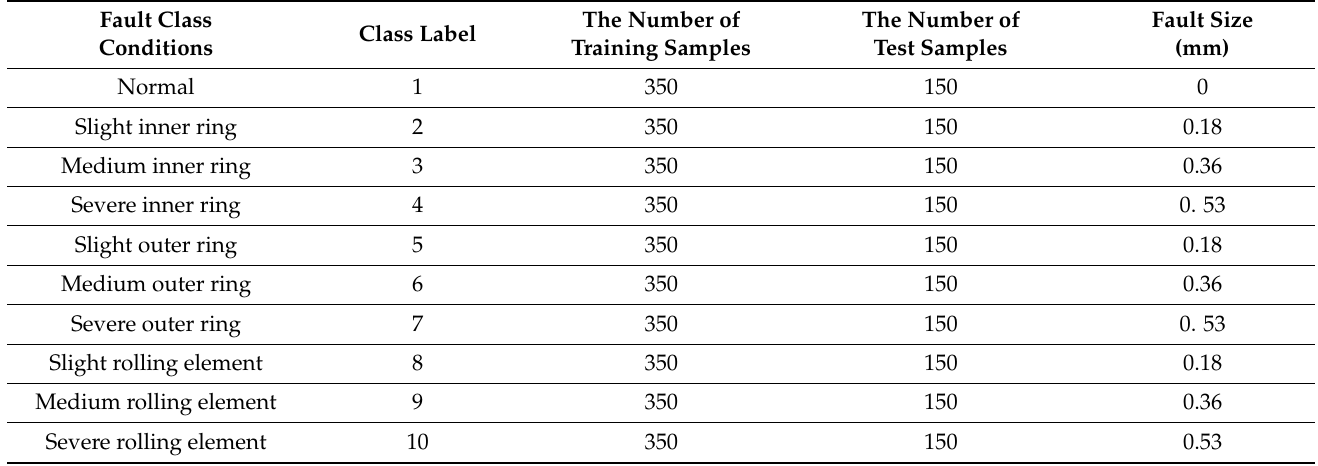
Table 1. The statistics of bearing fault dataset.